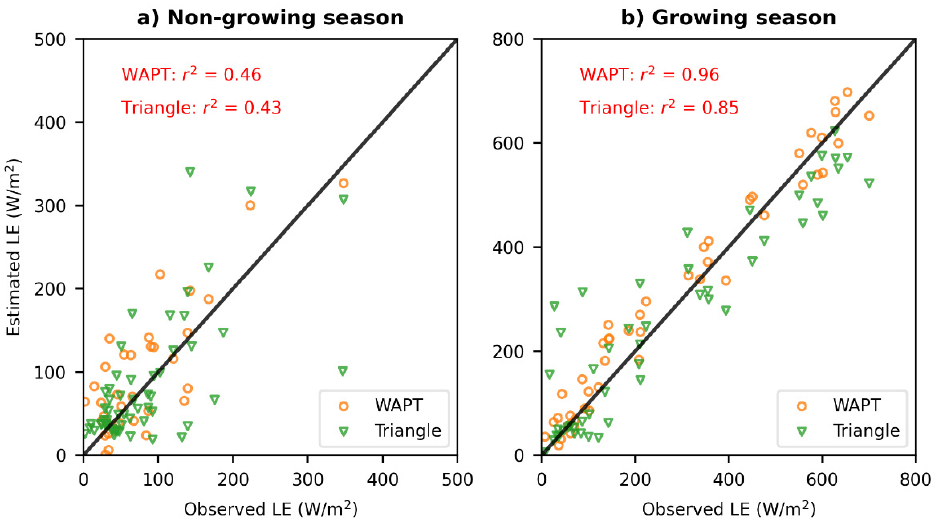
Figure 8. Estimated LE from WAPT and triangle models compared with observed flux during years 2013–2018: non-growing season (November to April) ( a ) and growing season (May to October) ( b ).